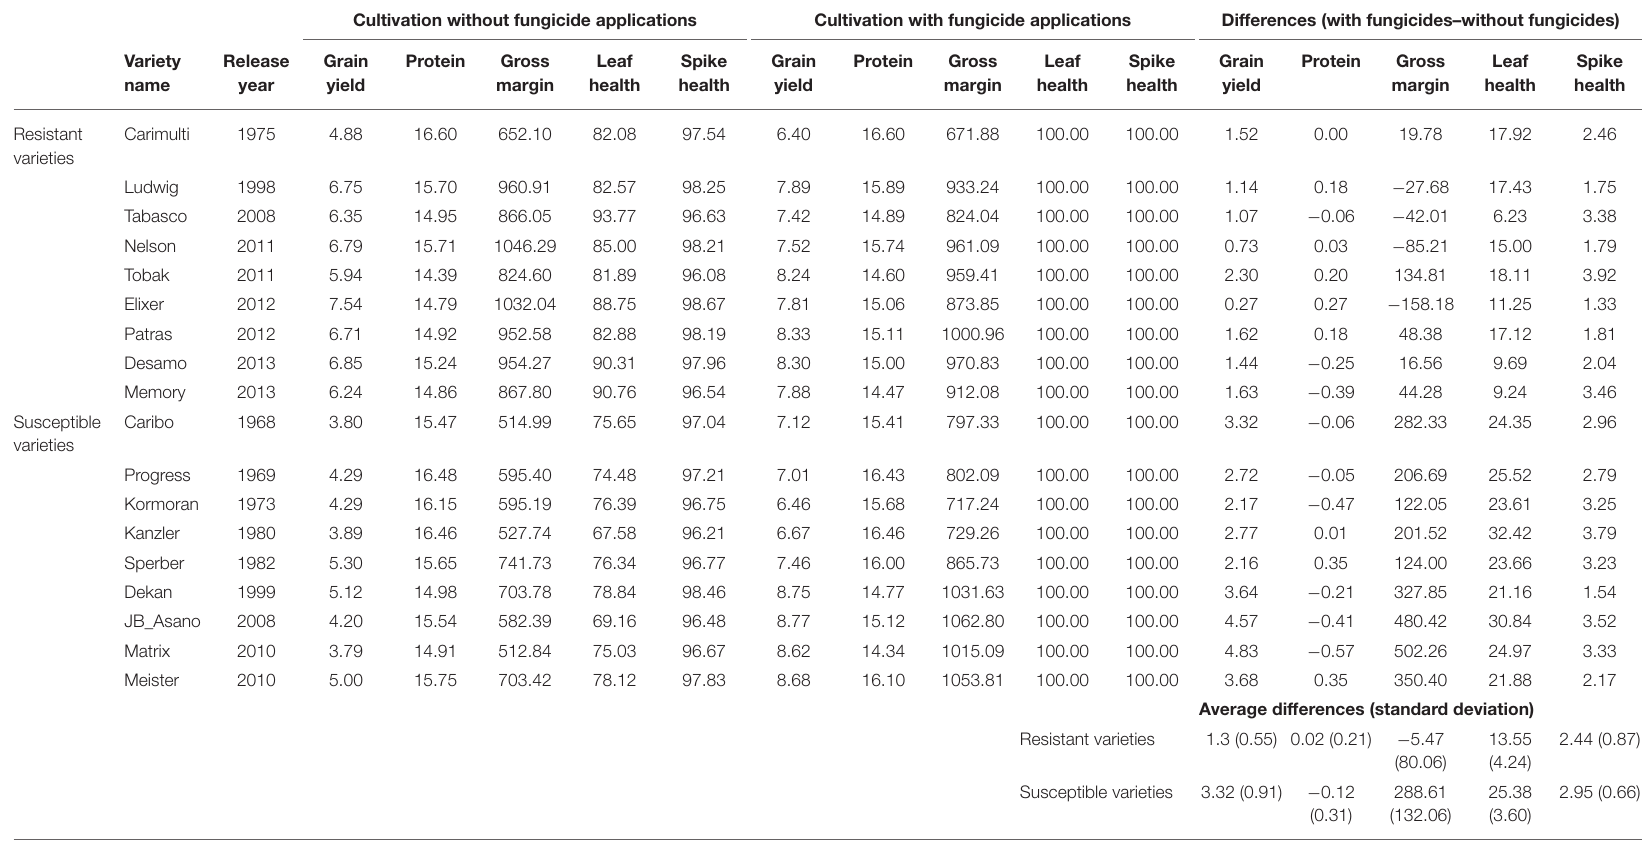
TABLE 7 | Subset of important susceptible and resistant German winter wheat varieties with the variables average grain yield (dt ha − 1 ), protein content (%), gross margin (EUR ha − 1 ), leaf and spike health (uninfected leaf or spike area in %) under the high nitrogen treatment, along with the differences between the variables for the cultivation with and without fungicide applications and average differences overall susceptible and resistant